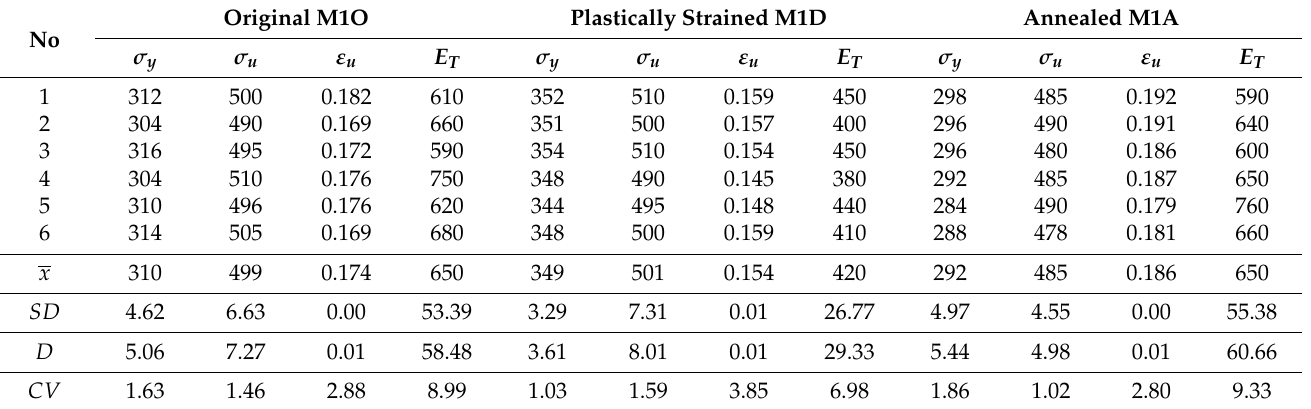
Table A1. Mechanical characteristics of materials, M1O, M1D, and M1A.